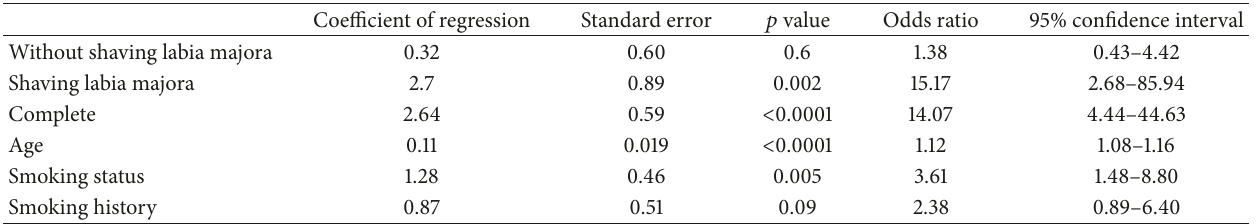
Table 3: Logistic regression of the occurrence of vulva dysplasia/VIN by the extent of hair removal, adjusted for age and smoking